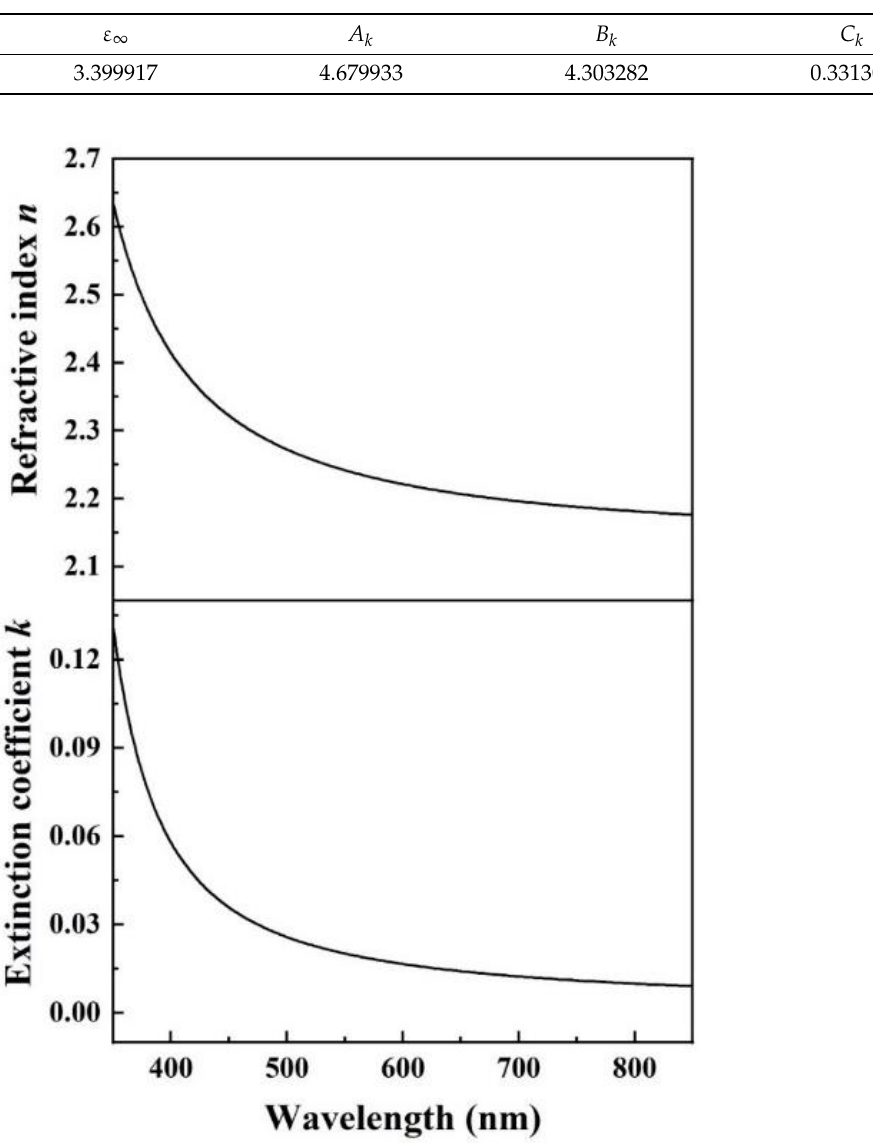
Table 2. The fitted constants obtained from the Lorentz oscillator model.